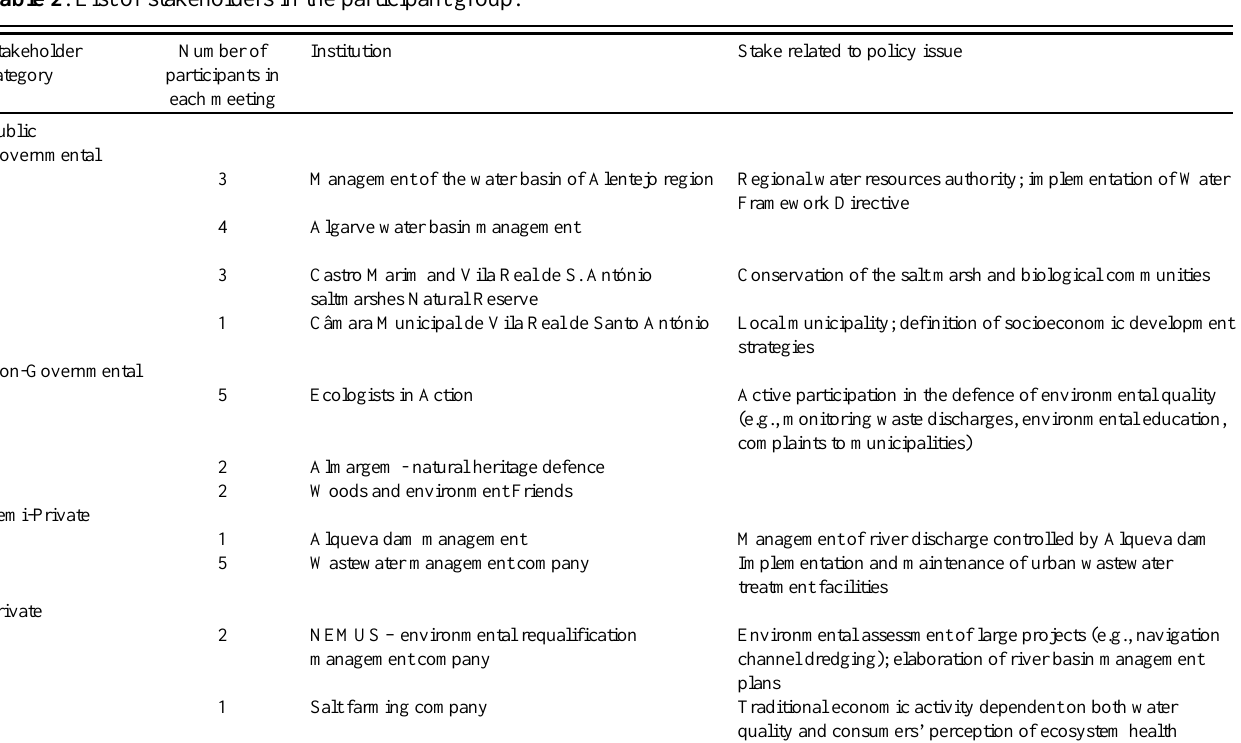
Table 2 . List of stakeholders in the participant